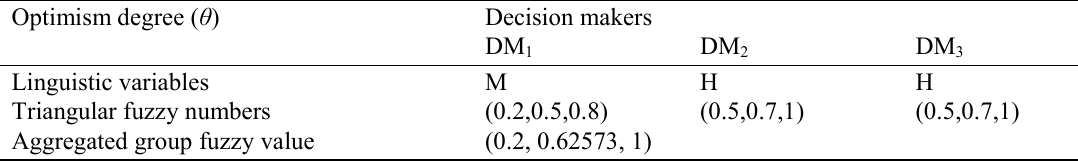
Table 4 Evaluation of optimism degree ( θ ) using linguistic variables.